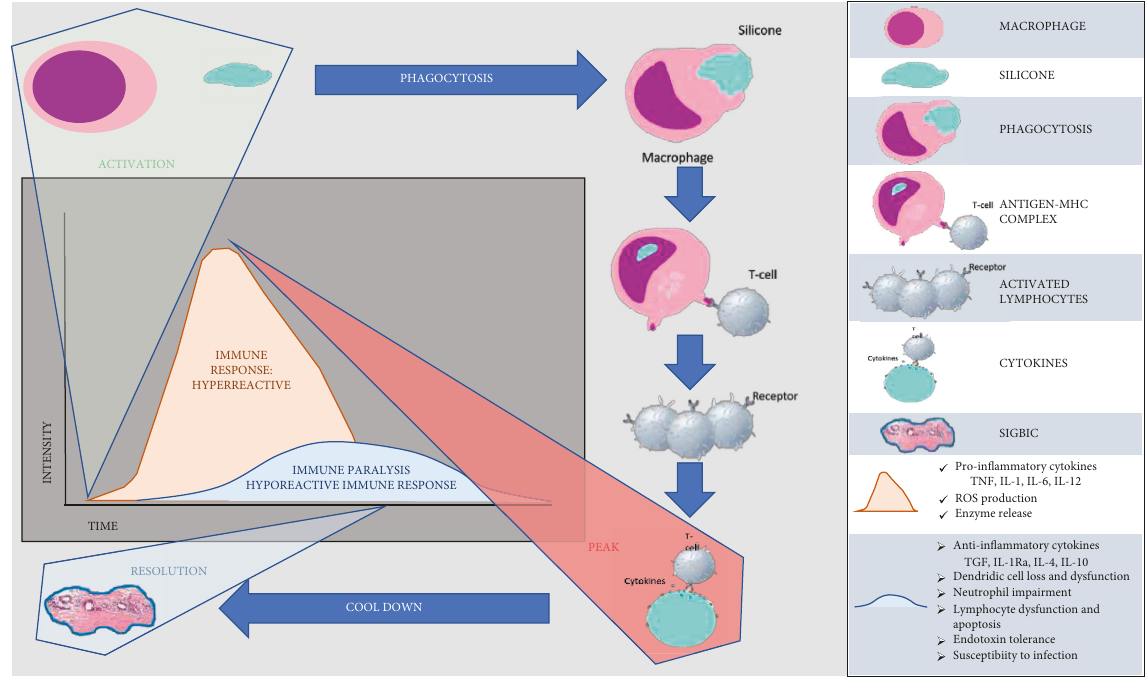
Figure 1: Flowchart demonstrating the silicone-induced granuloma formation flowchart in the fibrous capsule microenvironment. The macrophage phagocytes the free silicone in contact with the fibrous capsule, forming a macrophage antigen complex (MAC) and activating T lymphocytes by MAC. Silicone phagocytosis is frustrated, leading to apoptosis of the macrophage and release of the silicone corpuscles. Activated lymphocytes will release cytokines against the silicone. The process is usually self-limiting and results in granuloma (SIGBIC) formation that is the silicone disease marker.